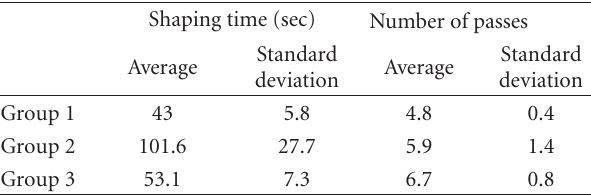
Table 3: Average shaping time (sec) and number of